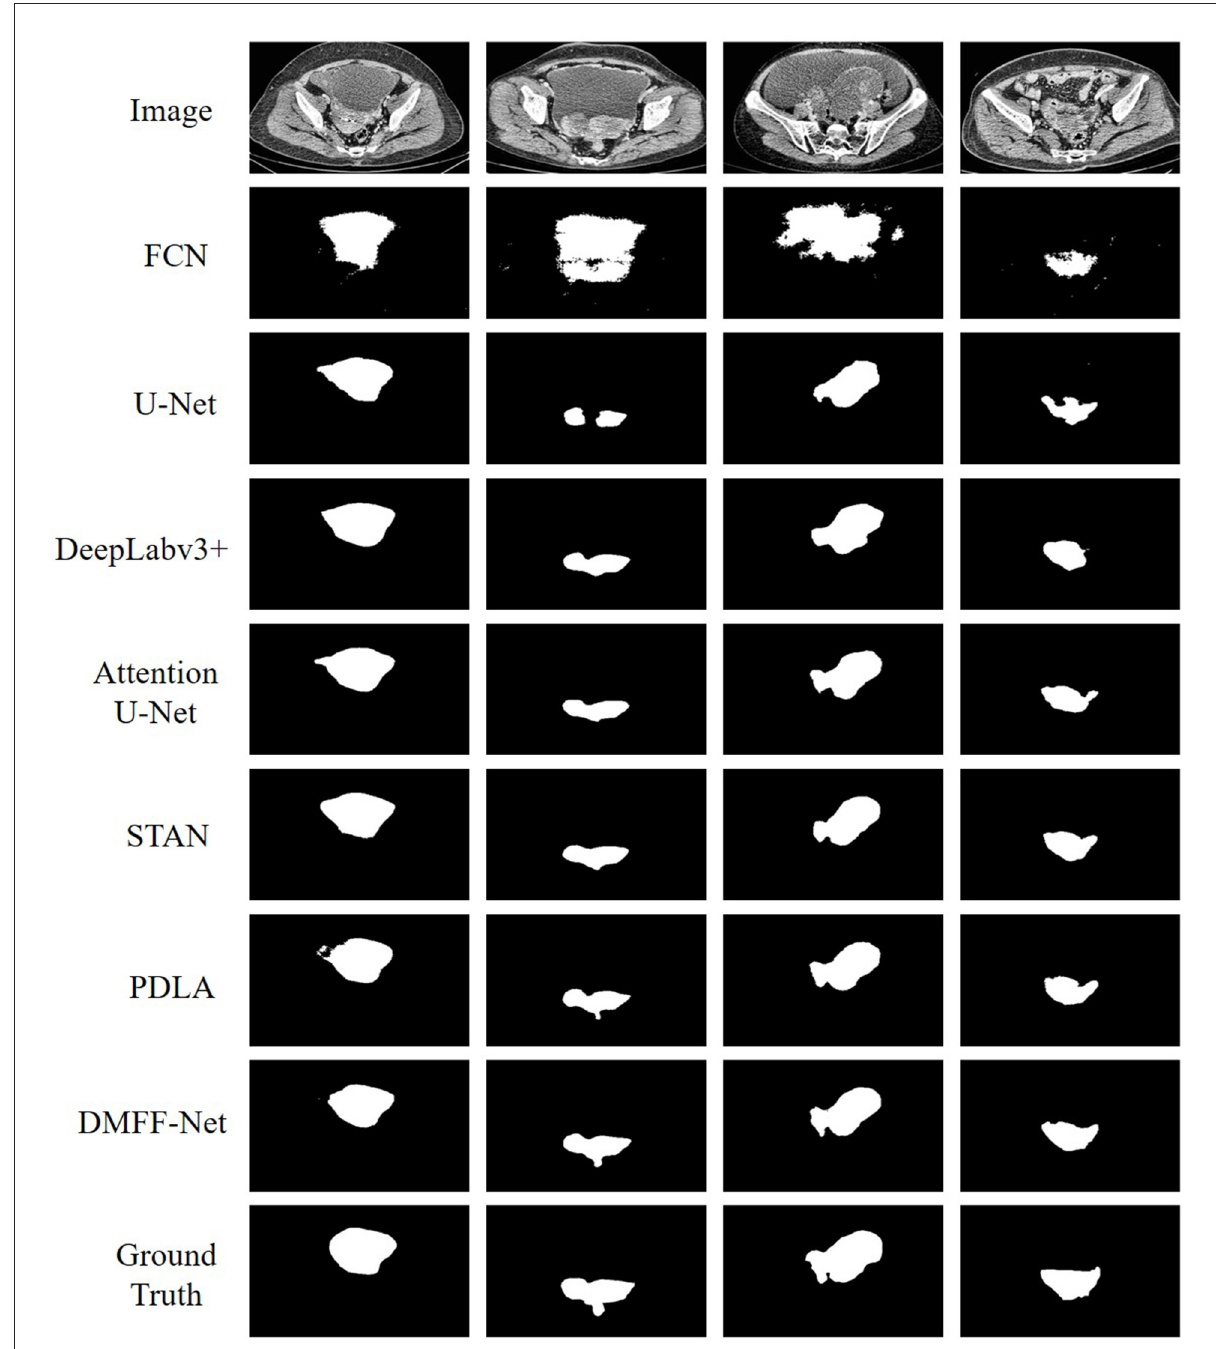
and the experimental results are shown in Table 3. The best performance is achieved when the quantity of convolution layers L is set to 10, and the worst performance is achieved when it is set to 4. This is because as the quantity of convolution layers